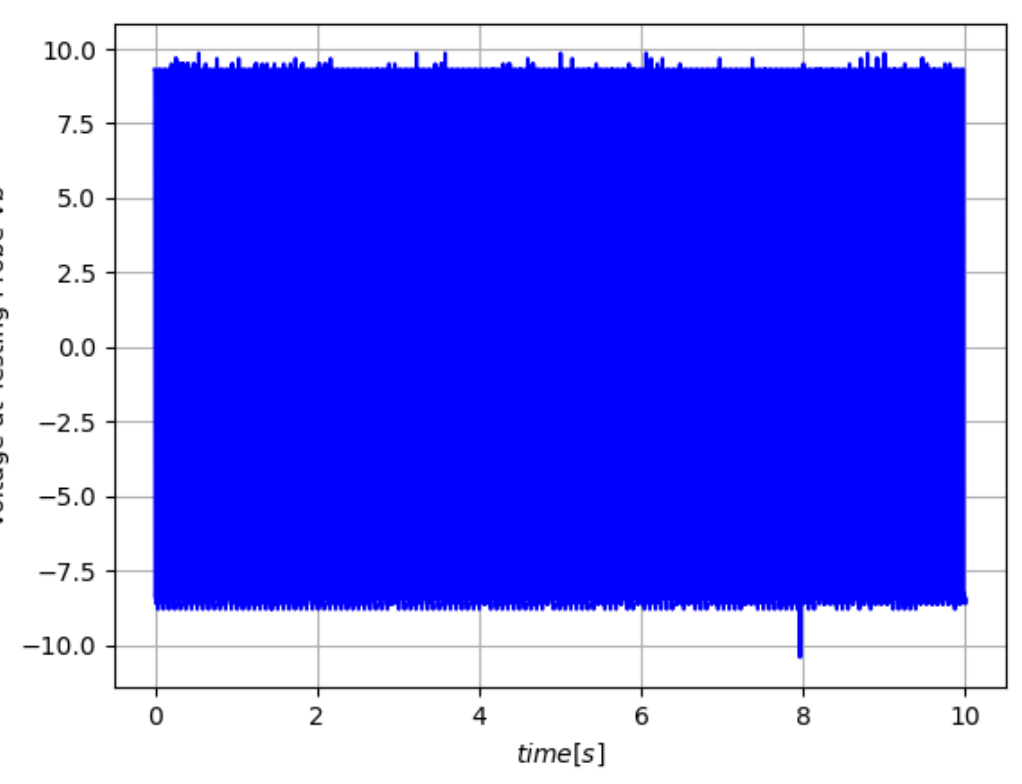
Figure 11. Experimental results.